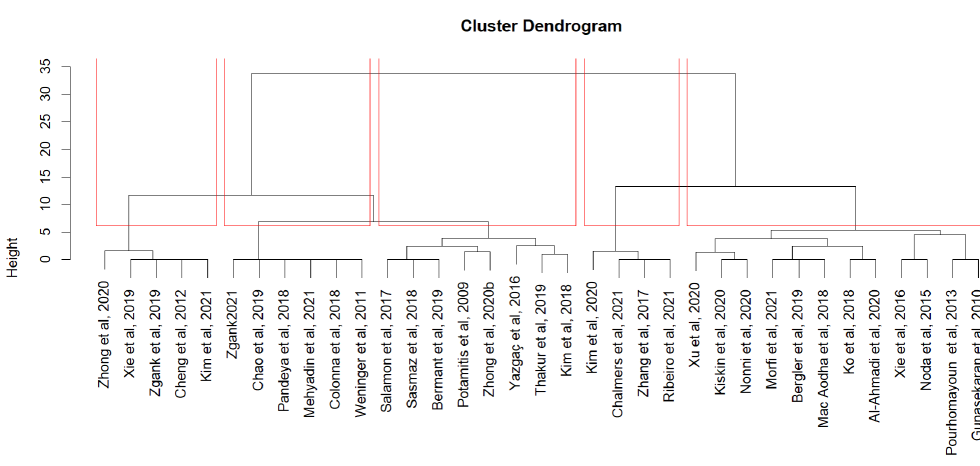
Figure 18. Focus Areas in bioacoustics